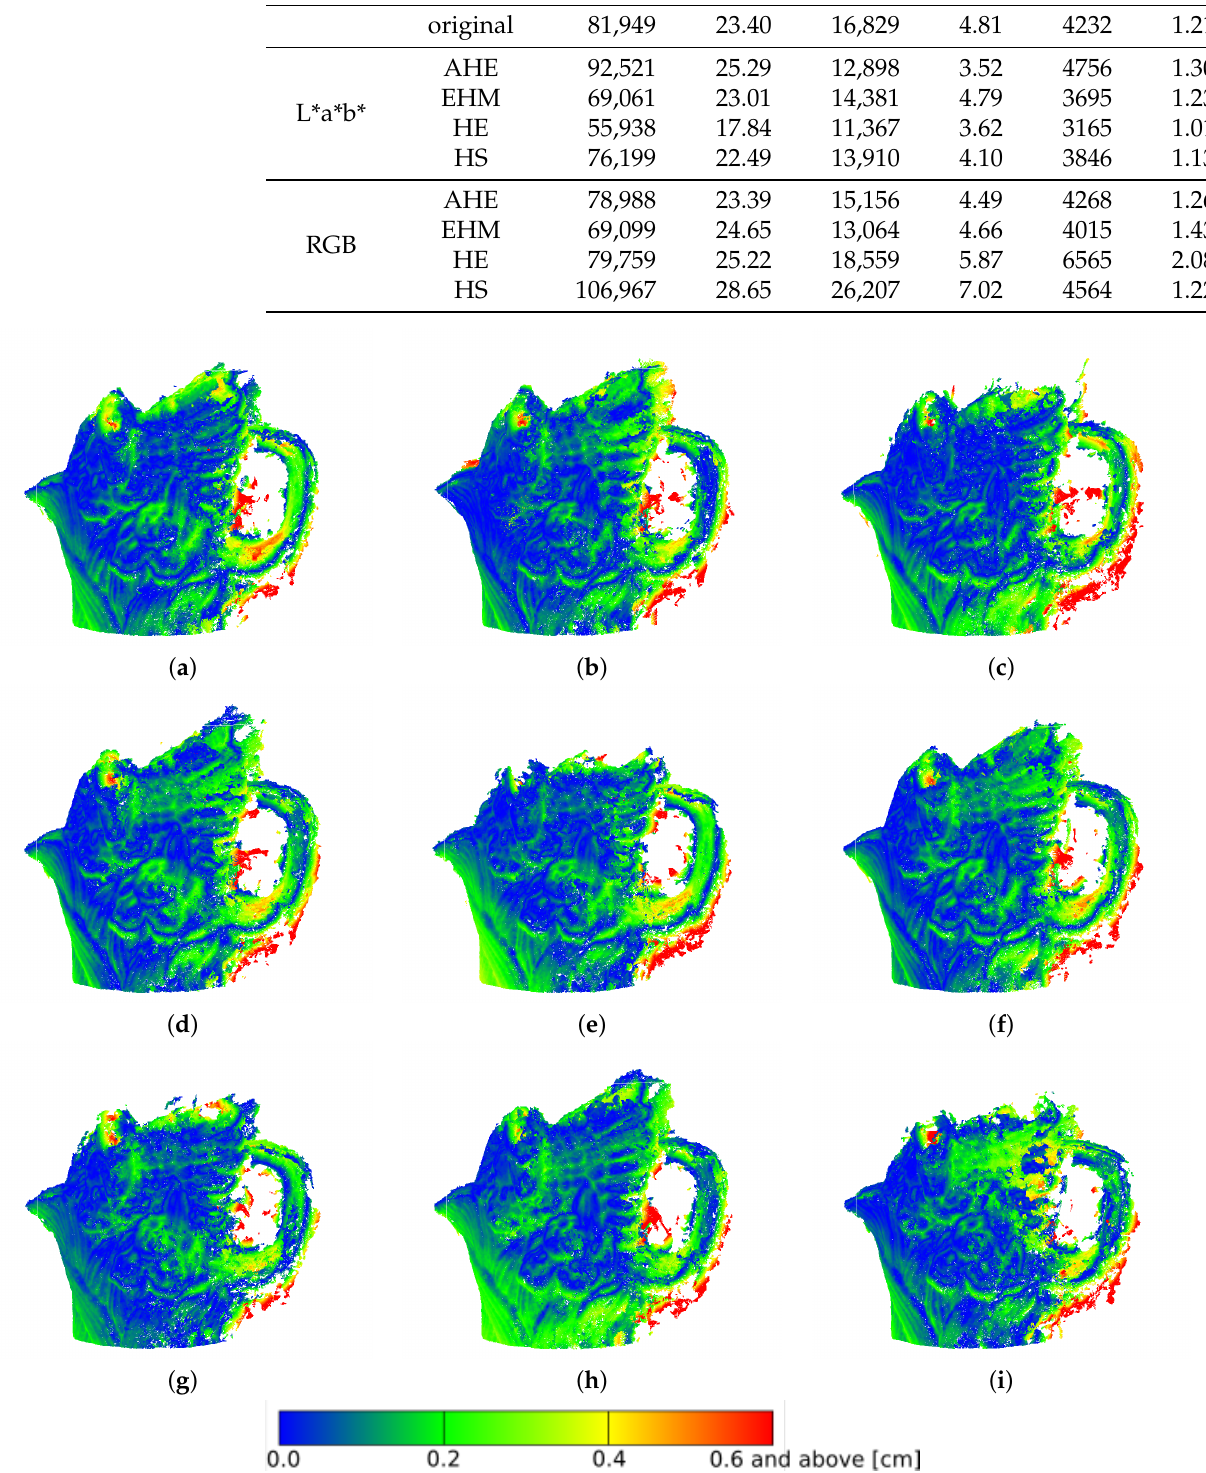
Figure 16. Dense point clouds of the porcelain figure. Distances to the model up to 3 σ = 0.6 cm: ( a ) original; preprocessed in the RGB space with the use of: ( b ) histogram stretching, ( c ) histogram equalizing, ( d ) adaptive equalizing, ( e ) exact histogram matching; preprocessed in the L*a*b* space with the use of: ( f ) histogram stretching, ( g ) histogram equalizing, ( h ) adaptive equalizing, ( i ) exact histogram